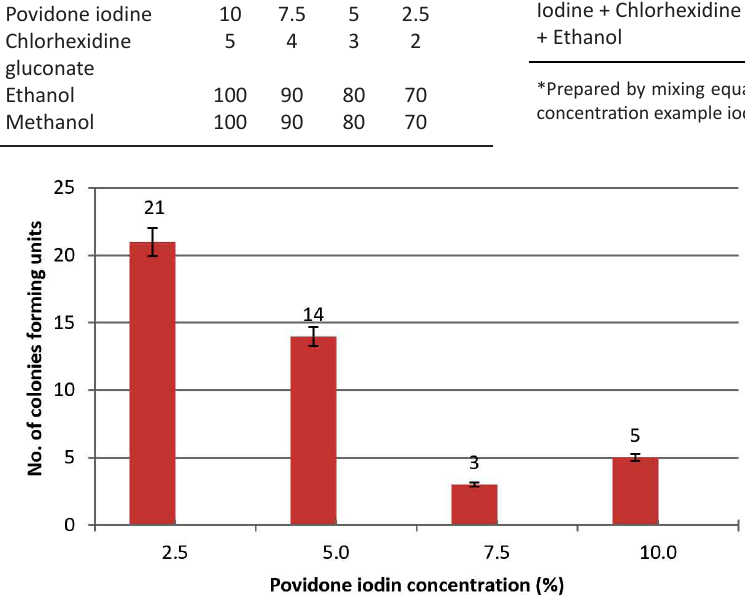
Table 1. Concentration of sterilizing agents SolutionConcentration (%)